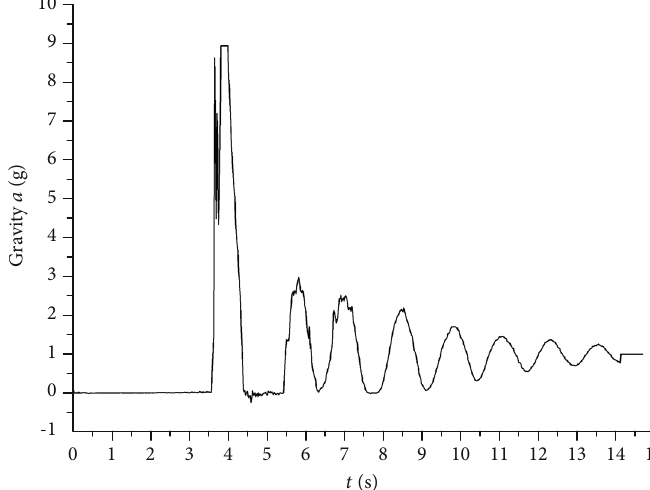
Figure 2: Gravity value during the drop tower test.